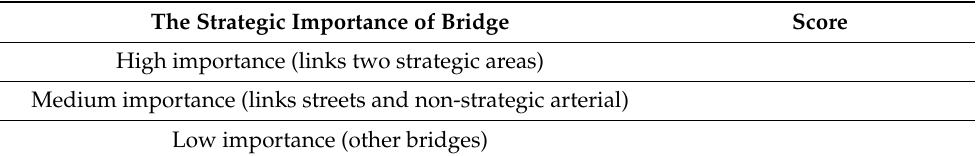
Table A8. Scores of the strategic importance